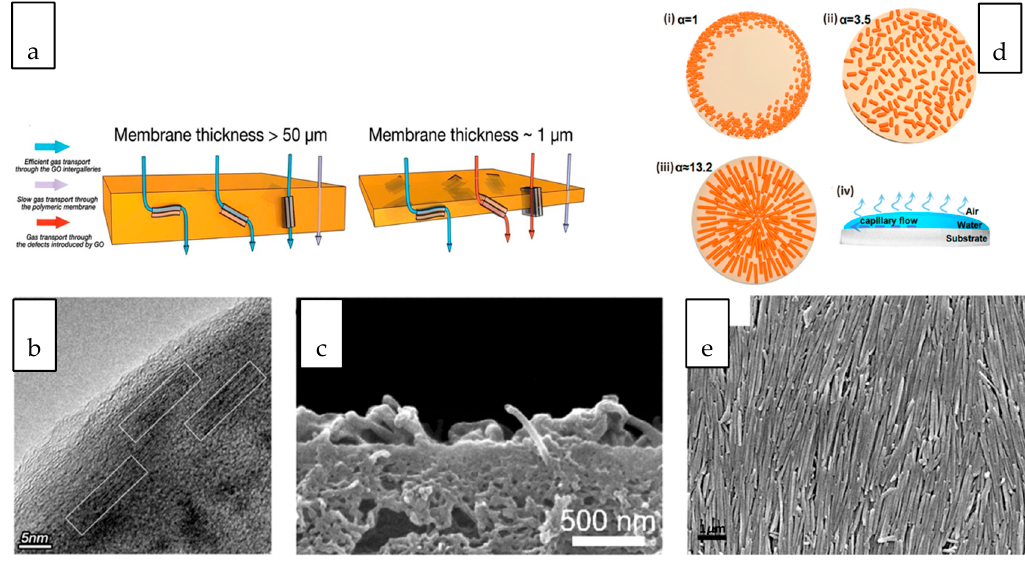
Figure 6. ( a ) Schematic illustration of gas transport pathway across membrane with different thickness [184] ( b ) Cross-sectional image of GO nanosheets aligned at parallel direction with membrane surface [184] ( c ) Cross-sectional images of nanocomposite membranes showing the protrusion of the tubes [185]. ( d ) Schematic illustration of nanomaterials with different aspect ratio ( α ) (i) coffee-ring effect observed in isotropic nanostructures, (ii) uniform distribution of ellipsoid nanostructures (iii) orientation of nanotubular nanostructure, (iv) evaporation deposition of nanomaterials on a substrate [186]. ( e ) Surface image of oriented HNT [186].